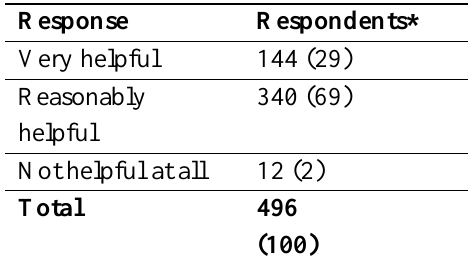
Usefulness of In-Text Questions to Understand Content